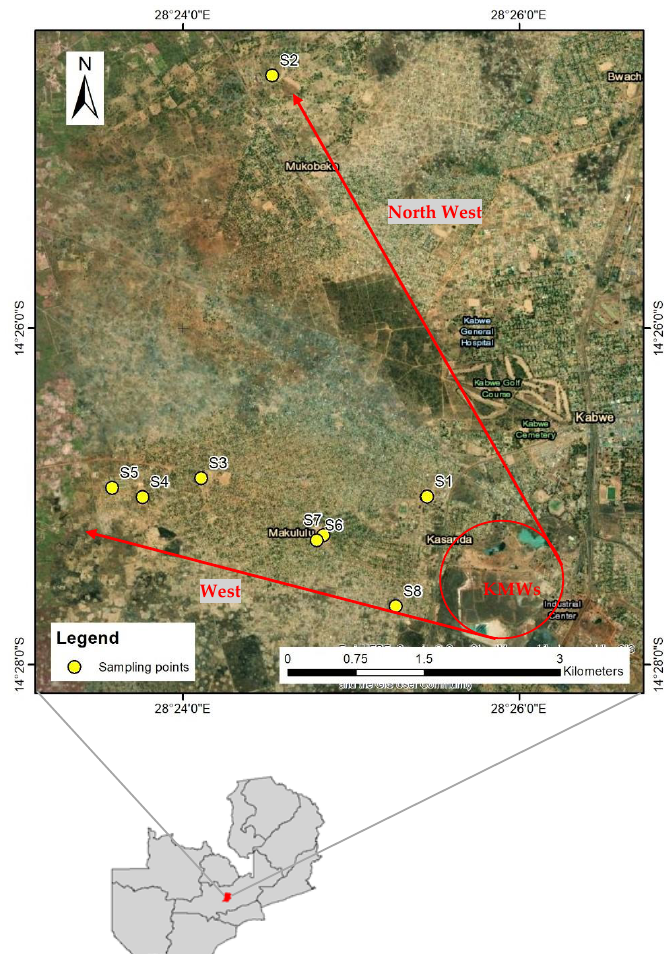
Figure 1. A map of Zambia with the sampling locations of Kabwe school playground soils (SPs): northwest direction (S1 and S2) and the west direction (S3, S4, S5, S6, S7, and S8) of Kabwe Mine Wastes